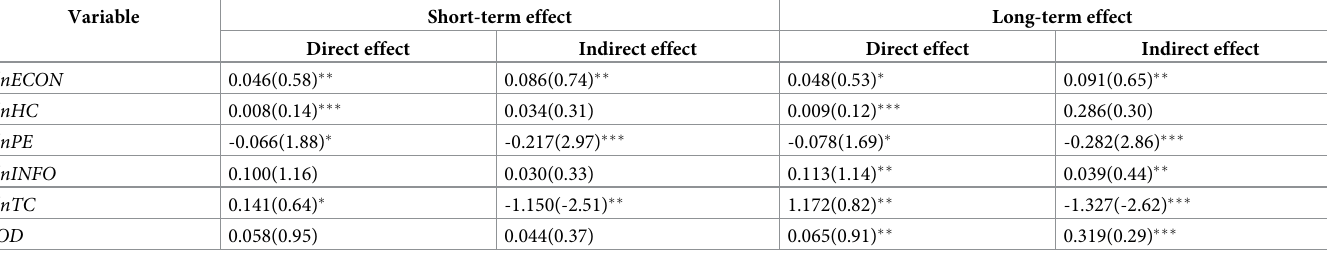
Table 6. Direct and indirect effects of the factors influencing culture and tourism integration efficiency.